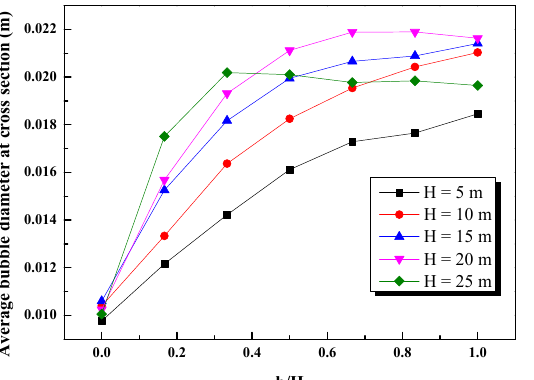
Figure 17. Average bubble diameter at different cross sections for various total column heights with U Gr of 0.0389 m/s.